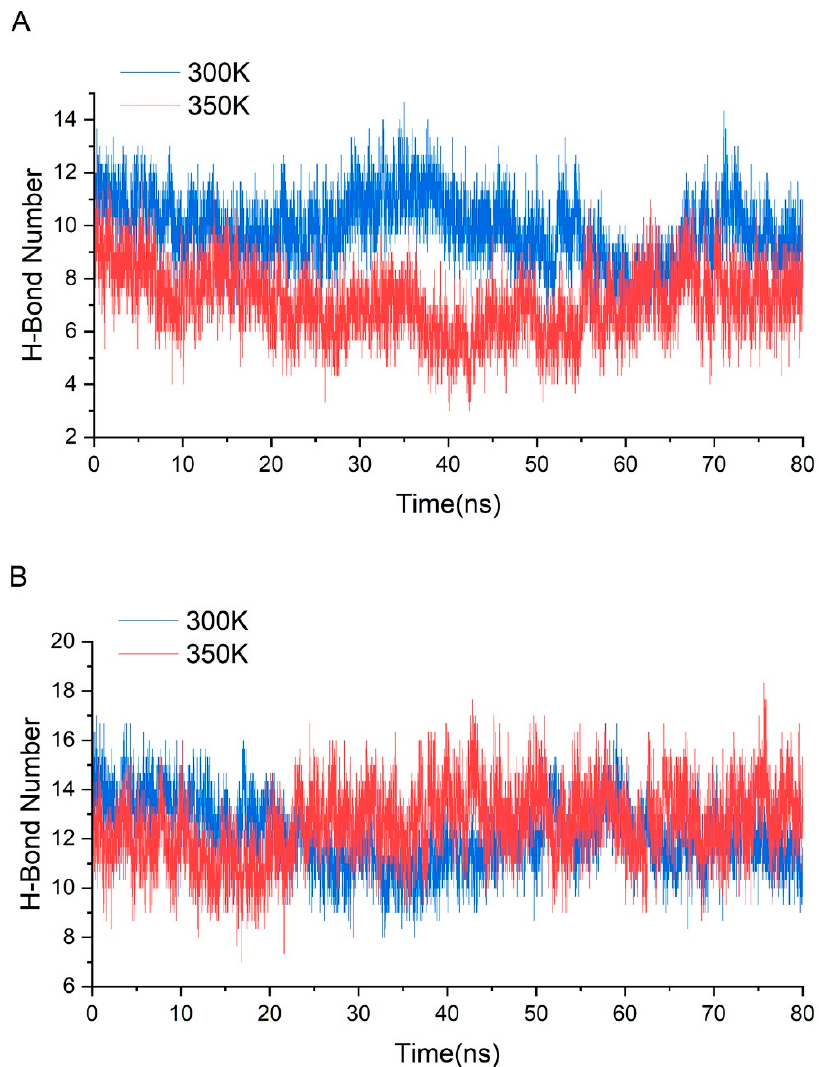
Figure A4. ( A ) shows the number of intra-group H-bonds and ( B ) shows the number of inter-group H-bonds in simulations at 300K and 350K.